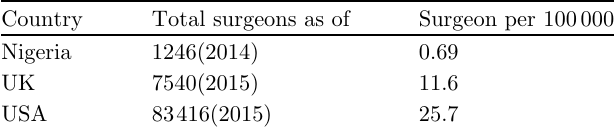
Table 4. Surgical workforce (surgeons) [29 – 32]. Table 5. Surgeons produced in Nigeria in the last 35 years